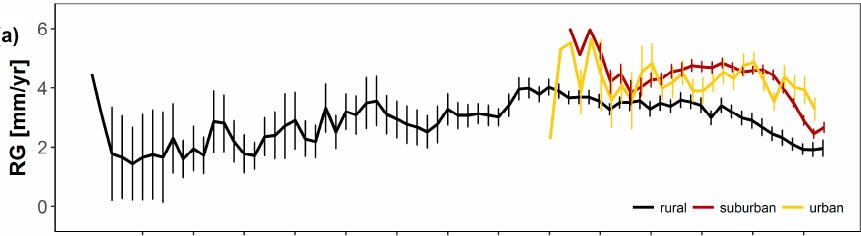
Figure 5. Radius growth, RG ( a ), indexed growth values RWI ( b ) and basal area increments BAI ( c ) with standard error bars for each value of A. sachalinensis trees sampled in rural, suburban and urban areas of Sapporo.